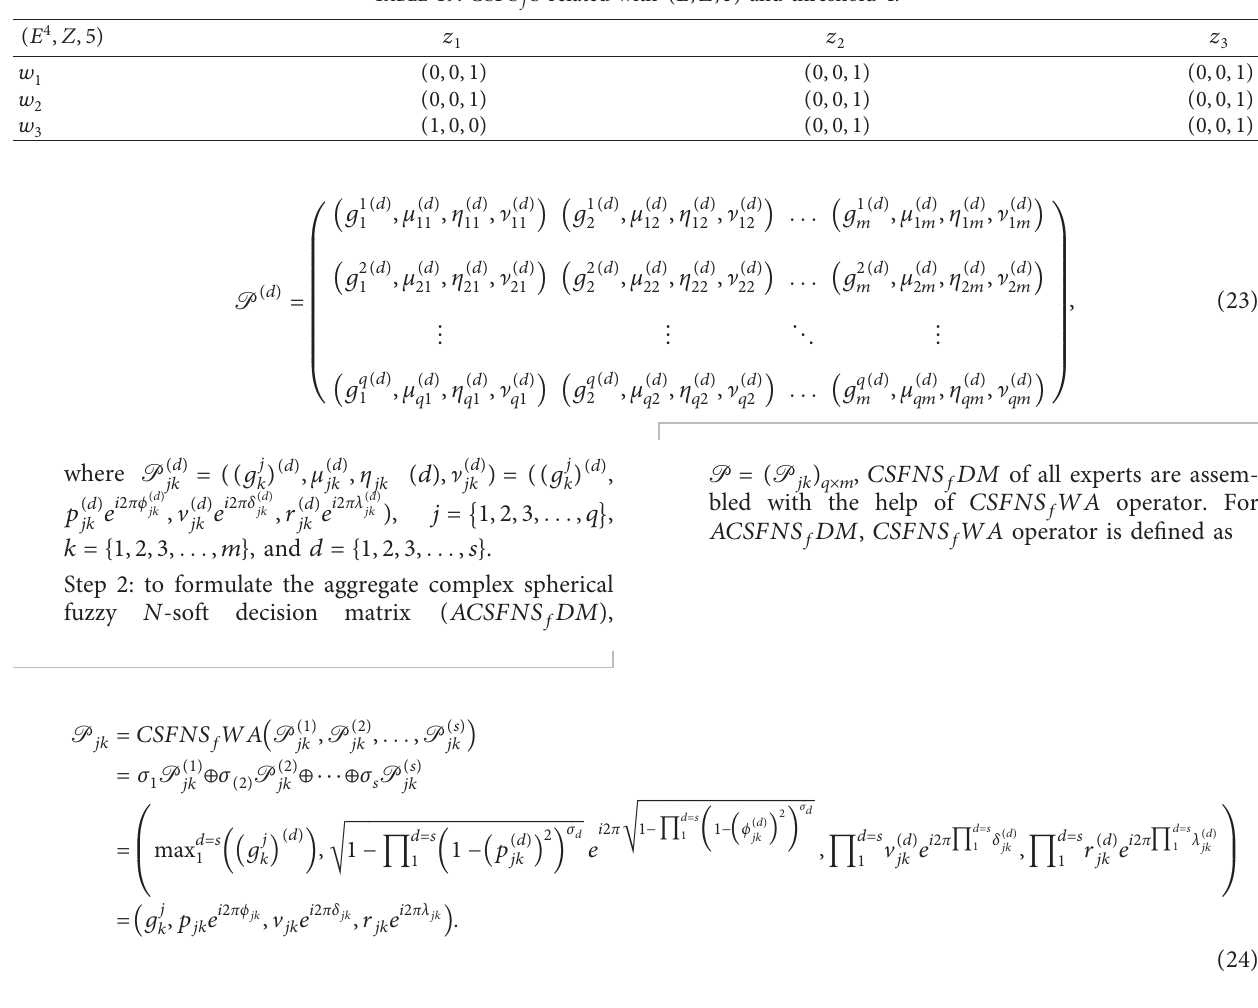
,Z, 5 ) and threshold 3. J